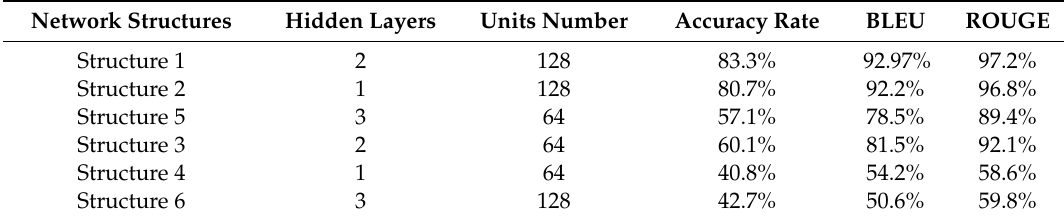
Table 5. Model performance comparison table of di ff erent network structures.